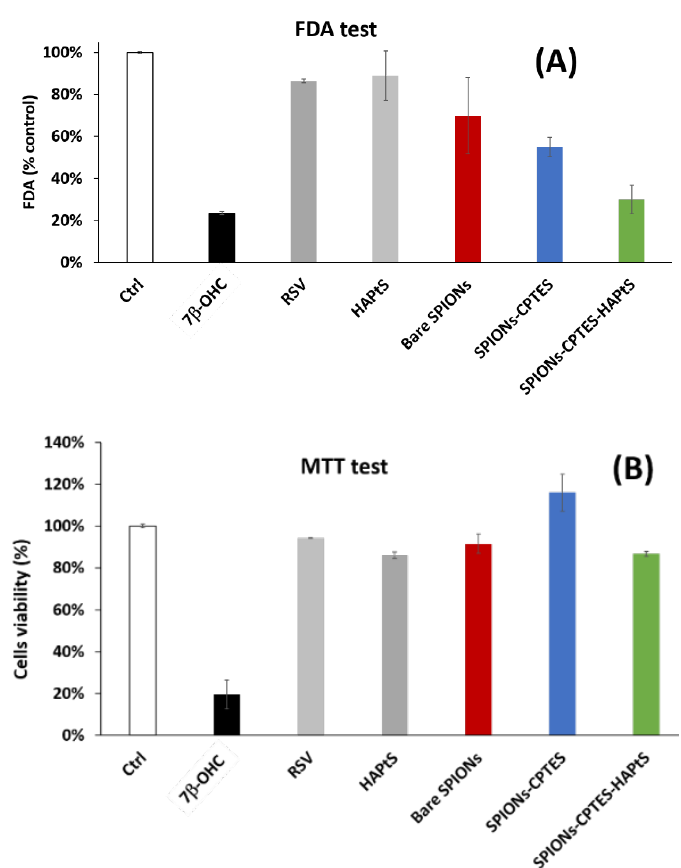
Figure 10. Cytotoxicity tests (( A ) FDA and ( B ) MTT) for control (Ctrl; untreated cells), positive cytotoxic control (7 β -OHC, 100 µ M), RSV (50 µ M), HAPtS (50 µ M in RSV equivalent), bare SPIONs (the same amount as in SPIONs-CPTES-HAPtS), SPIONs-CPTES (the same amount as in SPIONs-CPTES-HAPtS), and SPIONs-CPTES-HAPtS (amount equivalent to 50 µ M HAPtS). Incubation time of cells with molecules or nanoparticles was 24 h and cells are C6 rat glioma cells.